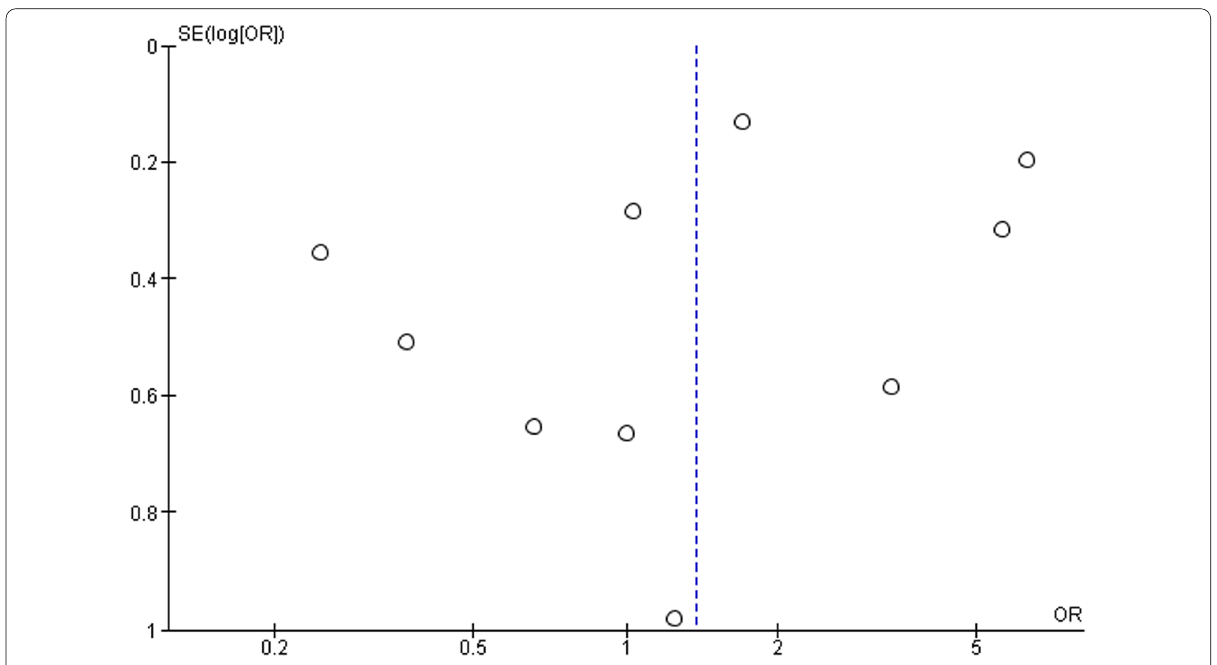
Fig. 7 Funnel plot for the assessment of publication bias